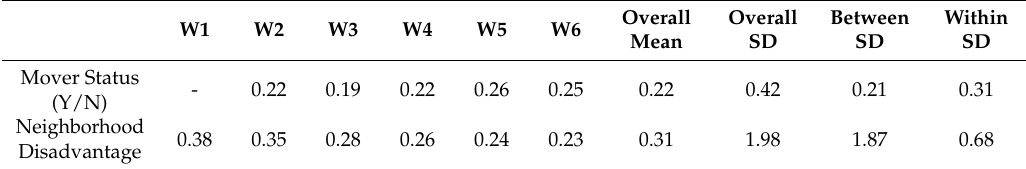
Table A2. Wave-Specific Measures of Neighborhood Disadvantage and Mobility